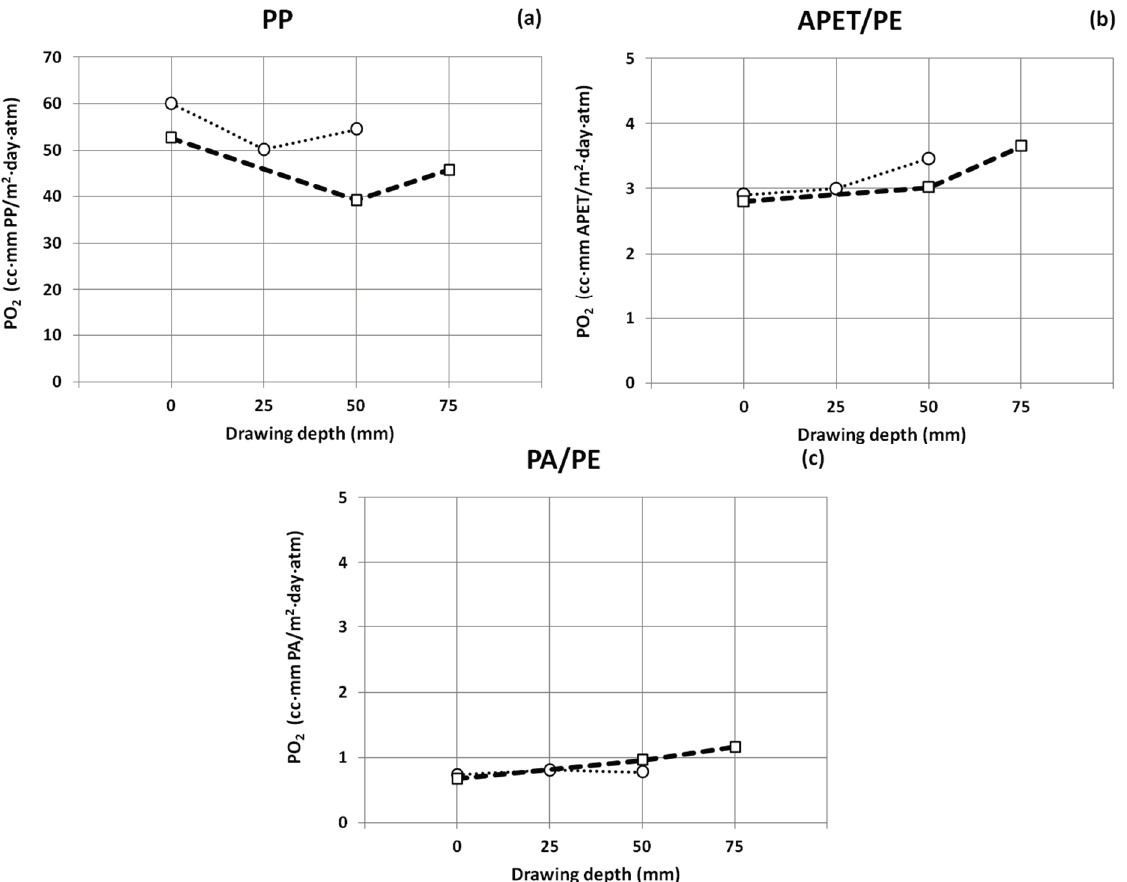
Figure 8. Permeability coefficients of PP ( a ), APET ( b ), and PA layers ( c ) in sheets and trays, expressed in cc·mm/m 2 ·day·atm as a function of the deep drawn depth. Connected symbols ○ and □ represent the PO 2 of the thin and thicker sheet variant of each material,